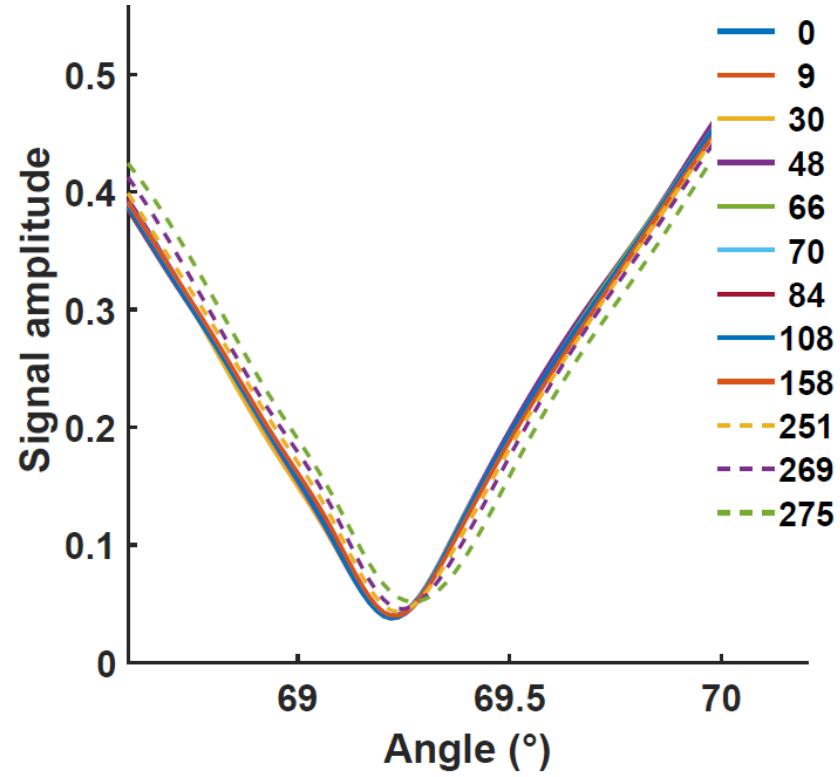
Figure 6. SPR curves for protected Cu thin films in contact with 20 mM PBS. The glass coverslide was coated with 46 nm of copper and protected with about 2 nm of Al 2 O 3. The alumina surface was exposed to an oxygen plasma treatment of 12 min. After 250 min in the solution, an angle shift started to appear (dashed lines). The time is given in minutes in the legend.